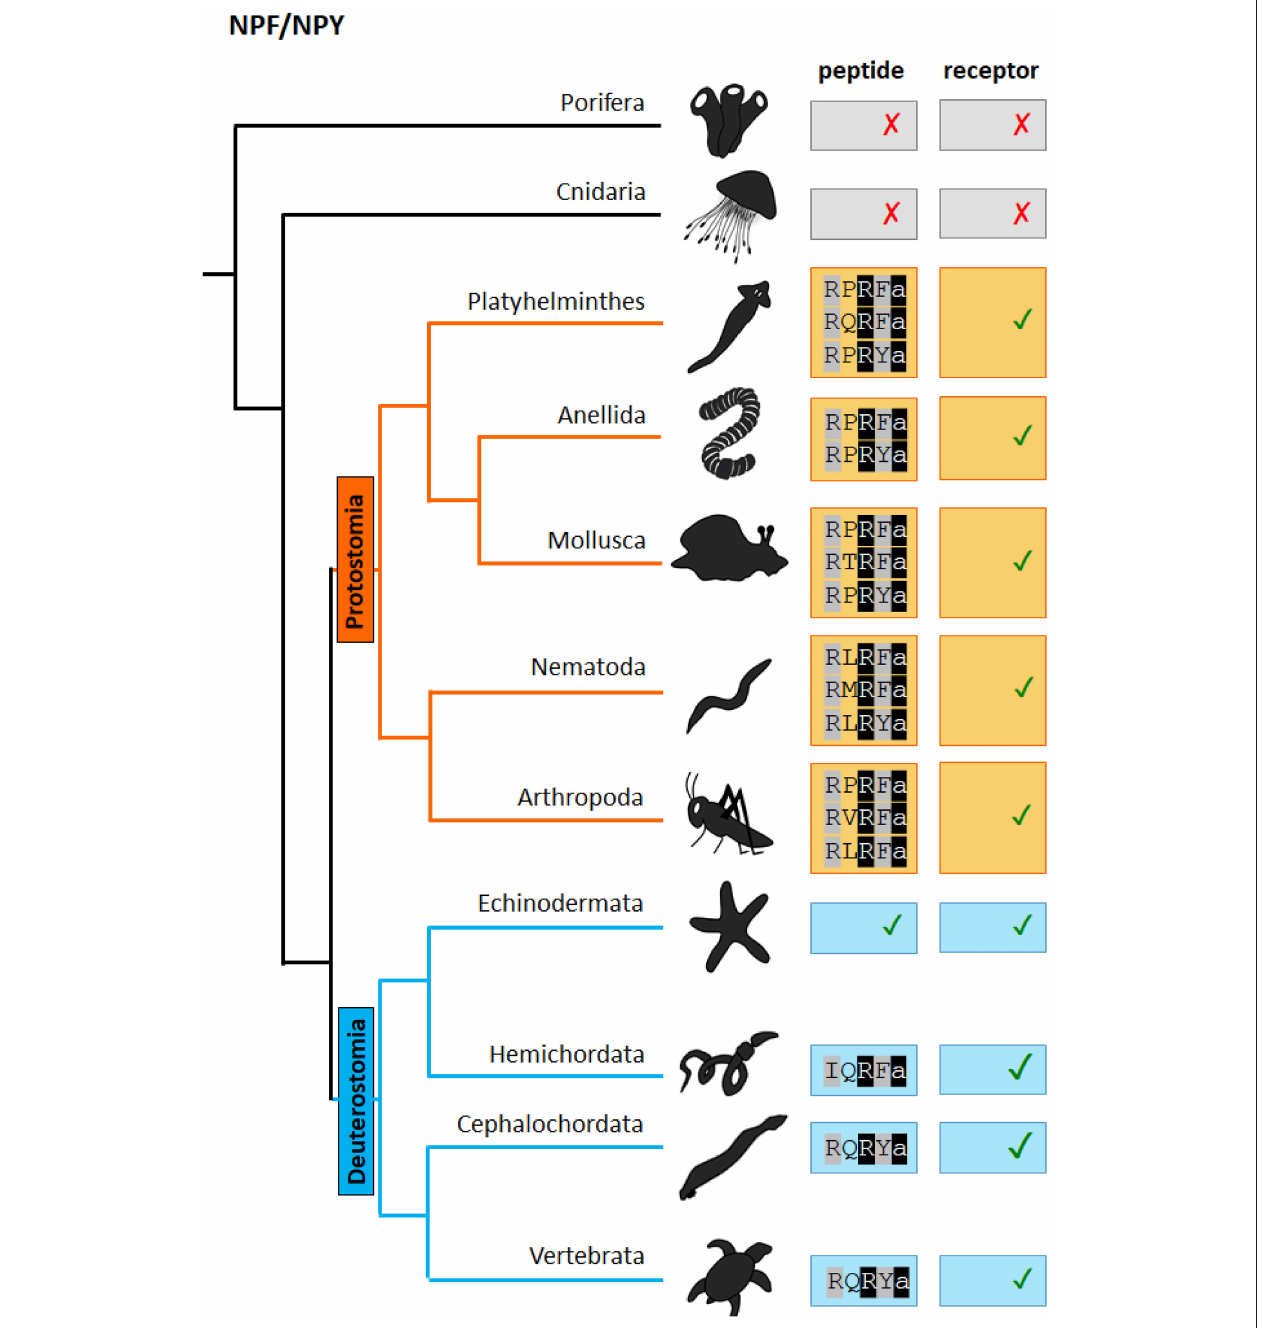
FIGURE 1 | Scheme of the presence of NPF/NPY neuropeptides and receptors in distinct phyla of the metazoan evolutionary tree. The NPF(Y) C-terminal sequence motif is indicated. “ 3 “ and “ 7 ,” respectively represent the presence or absence of the peptide/receptor in the corresponding phylum. Evidence for the presence of both NPY/F peptides and receptors in cephalochordates and hemichordates can be found in Elphick et al.